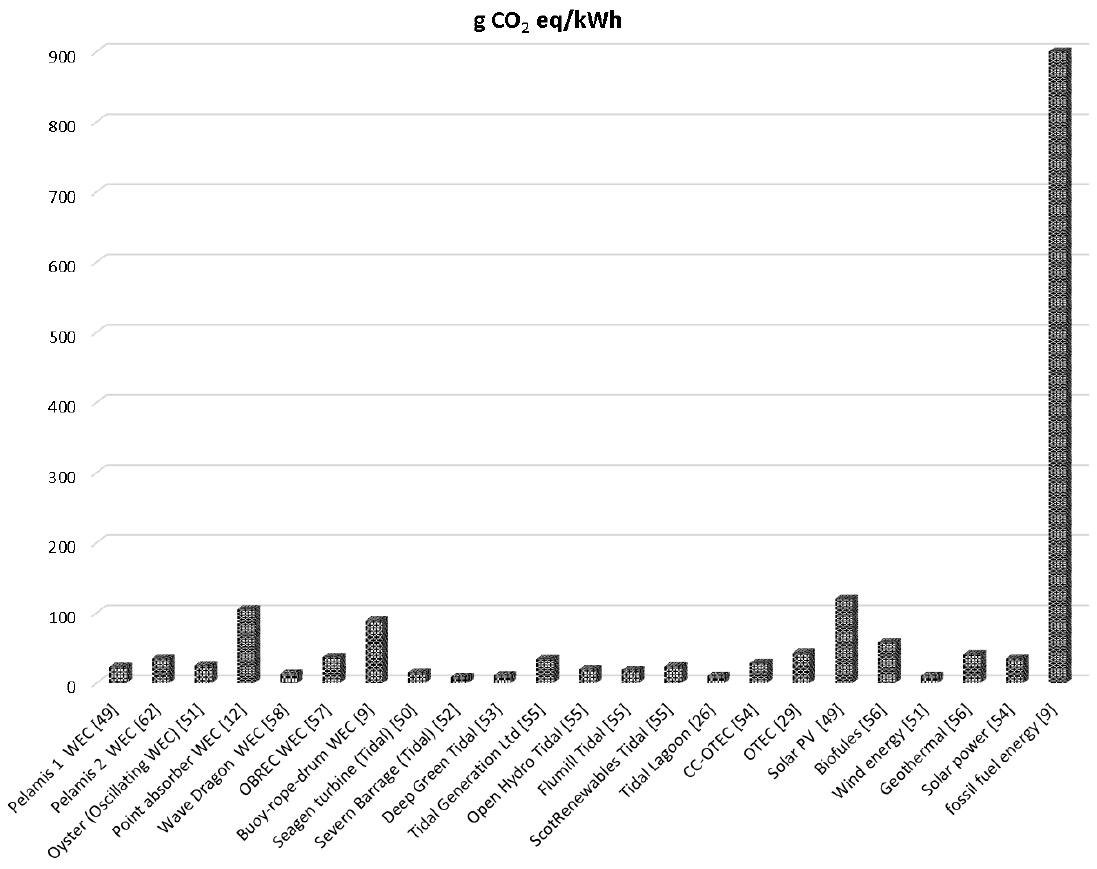
Figure 5. CO 2 emissions of ocean energy technologies (OET) compared with other generation energy systems.